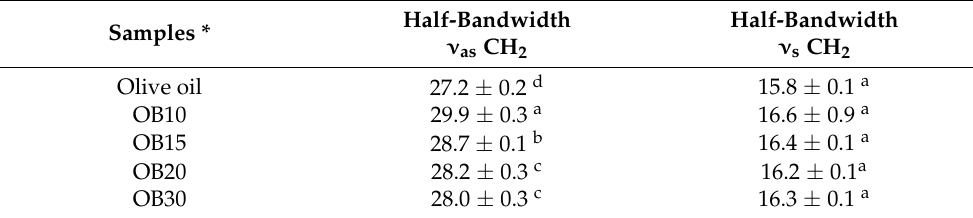
Table 3. Half-bandwidths of the ν as CH 2 (approx. 2923 cm − 1 ) and ( ν s CH 2 ) (approx. 2853 cm − 1 ) bands of pure liquid olive oil and oat bran